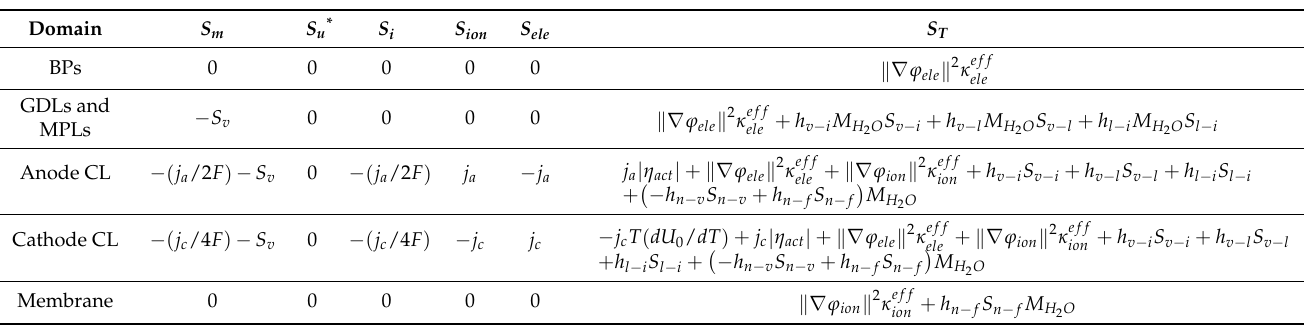
Table 3. Source terms excluding those for